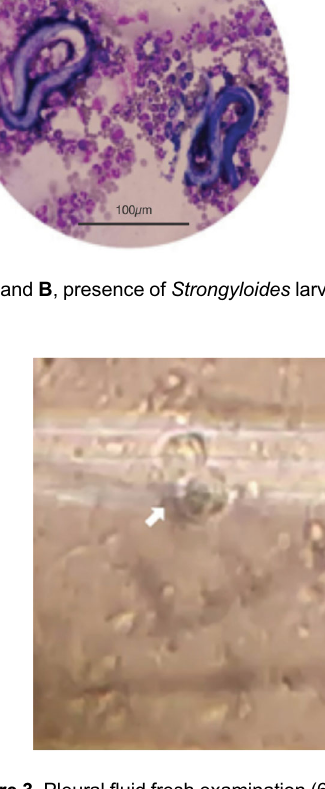
Figure 3. Pleural fl uid fresh examination (600 (cid:1) , scale bar: 10 m m) showing fl agellated forms of Trichomonas sp.